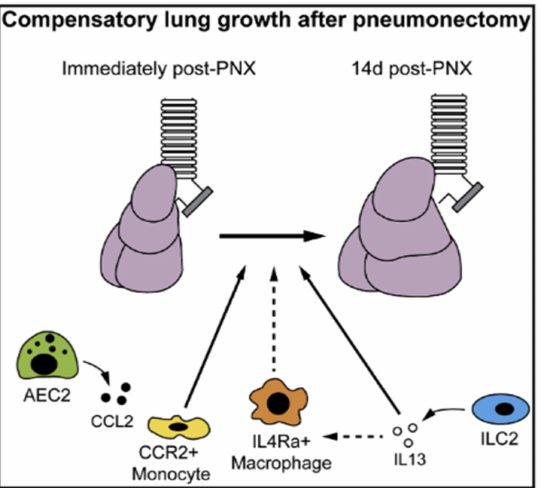
Figure 3. Graphical abstract of post-pneumonectomy compensatory lung growth in potential im- munomodulatory therapies. (AEC2: Type 2 alveolar epithelial cells; CCL2: C-C Motif Chemokine Ligand 2; CCR: C-C chemokine receptor 2; IL4Ra: interleukin 4 receptor; IL13: Interleukin 13; ILC2: Type 2 innate lymphoid cells). Adapted from [124]. Copyright 2017 Cell